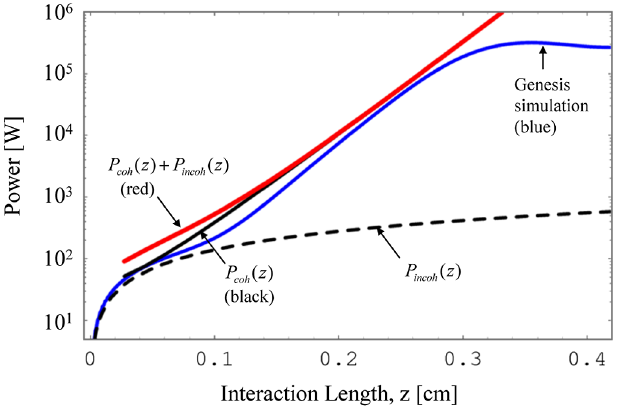
FIG. 9. (Color) Power versus interaction length for a laser- pumped FEL (cold beam) with parameters listed in Table I. Curves denote coherent power (solid black), incoherent power (dashed), total theoretical power (red), and the result of a FIG. 10. (a) GENESIS simulation result showing transverse pro- GENESIS simulation (blue). The theoretical efficiency is (cid:11) ¼ file of intensity (solid curve) at z ¼ 0 : 35 cm (saturation) for the Þ ¼ 0 : 008% . The efficiency observed in the =L 0 : 023 ð (cid:2) laser-pumped FEL. The dashed curve denotes electron beam o go profile. (b) Distribution of power over normalized transverse GENESIS simulation is 0.01%. In calculating the incoherent and wave number (propagation angle), for the intensity profile shown coherent power from Eqs. (26) and (30), we used the maximum in (a). The propagation angle is normalized to the diffraction (cid:9) (cid:2)= ð 2(cid:3) Þ ¼ 5 (cid:5) angle resolved by the simulation, i.e., (cid:7) x sim . The maximum angle resolved by the simulation is angle (cid:7) ¼ 1 : 6 (cid:1) m is the transverse grid size. In this 10 (cid:4) 4 rad , where (cid:3) D x ¼ 70 (cid:7) (cid:7) . The maximum theoretical propagation angle is (cid:6) (cid:7) , where (cid:7) is the maximum parameter regime, (cid:7) k; max D k; max k; max sim (cid:9) 500 (cid:7) (cid:7) propagation angle of the coherent radiation given by Eq. (16). k; max D